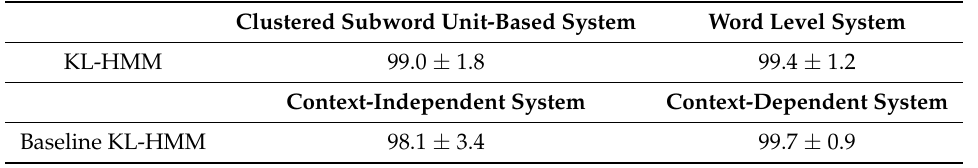
Table 2. KL-HMM-based subword unit- and word level -based systems results on the PhoneBook database using posterior distributions as